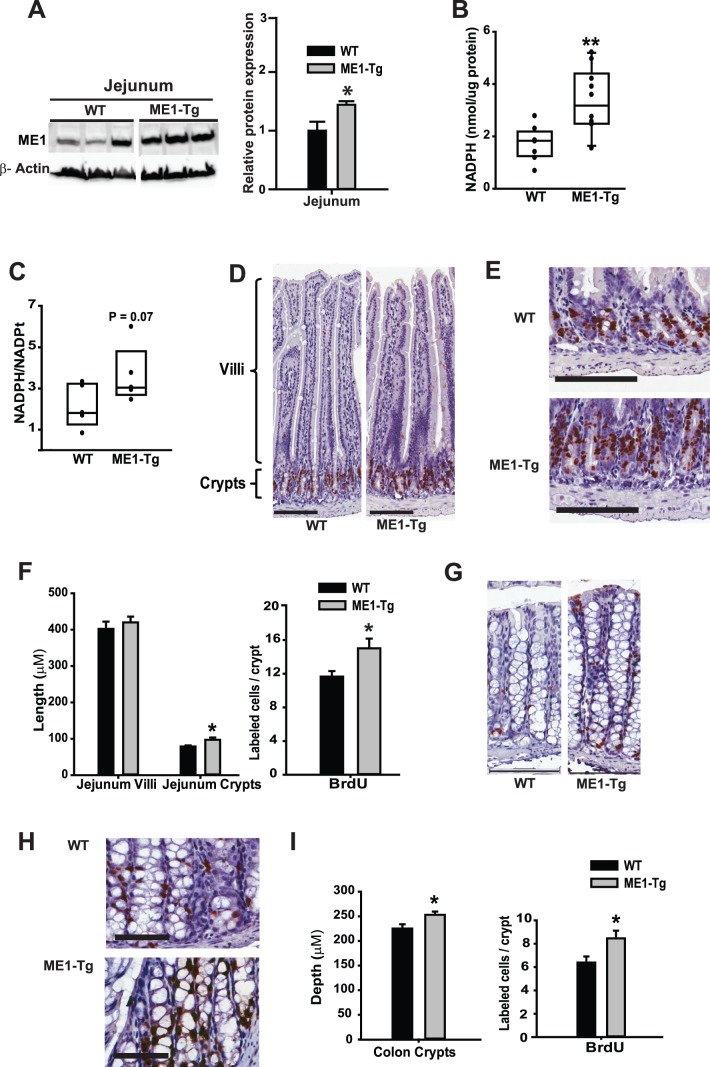
Increased crypt cell proliferation in jejunums of ME1-Tg mice fed HF diet.A) Western blot of ME1 protein and corresponding band densitometry analysis of WT and ME1-Tg mice fed HF diet (Exp. 2). B) ME1 enzyme activity in the jejunum of WT and ME1-Tg mice. Each data point represents an individual mouse. C) Tissue ratio of NADPH/NADPt in jejunum samples of WT and ME1-Tg mice. D–E) Representative images of jejunum villi, crypts, and BrdU staining of WT and ME1-Tg mice; scale bars = 100 µM (D and E). F) Quantification of jejunum villus height and crypt depth, and BrdU staining of jejunum of WT and Me1-Tg mice (Exp. 2). G–H) Representative images of colon crypts, and BrdU labeling of WT and ME1-Tg mice; scale bars = 100 µM (G) and 50 µM (H). I) Quantification of colon crypt depth, and BrdU staining of colons of WT and Me1-Tg mice (Exp. 2). Significant differences at *P<0.05 and ** P<0.01 between genotypes. P values are indicated for those values tending to exhibit significant differences between groups (0.05<P<0.10). For panels B, C, F and I, data were from 5–6 mice/group.